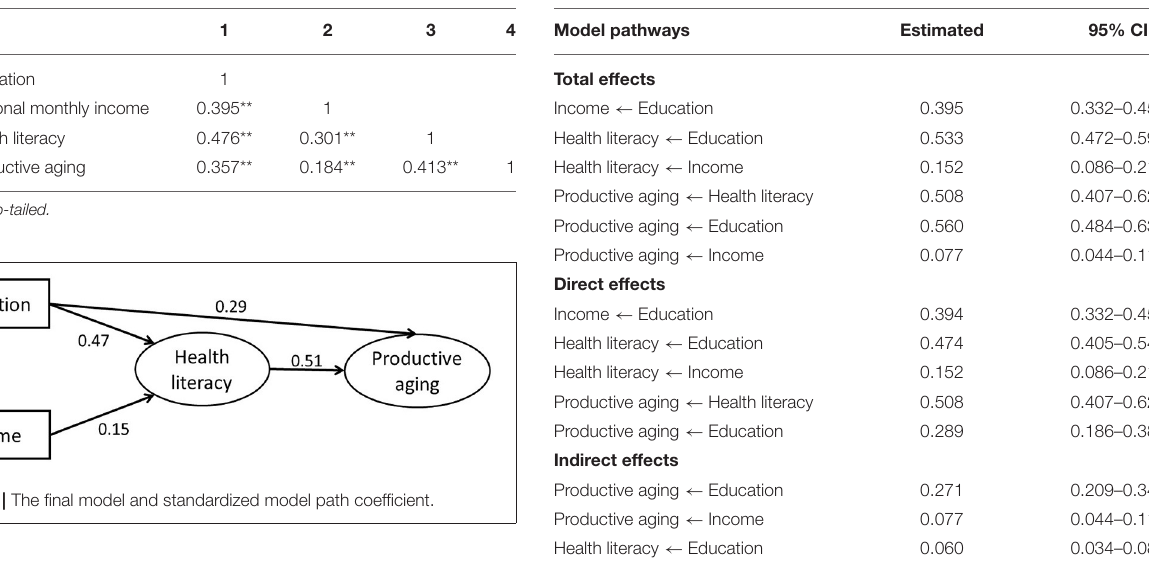
TABLE 5 | Significance test of the mediating test.